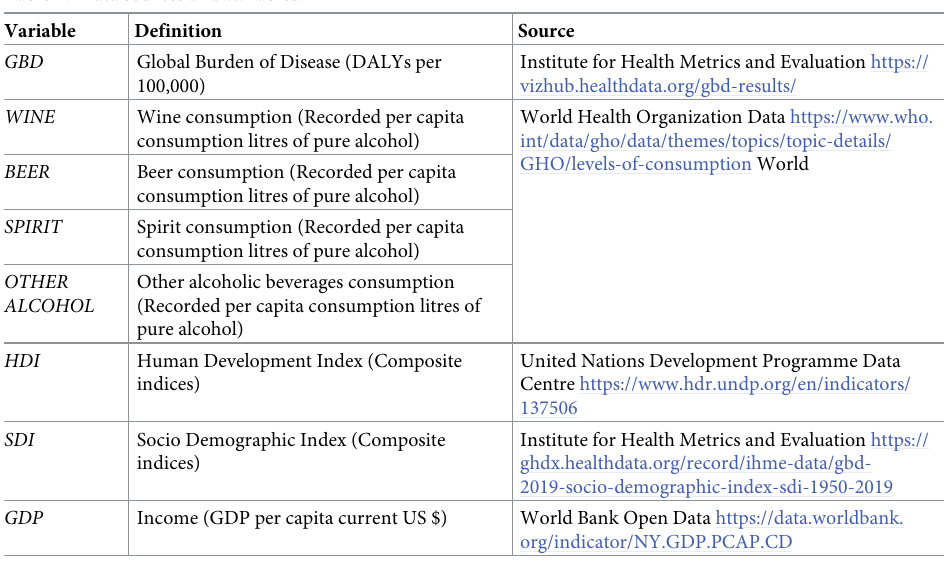
Table 1. Data sources and